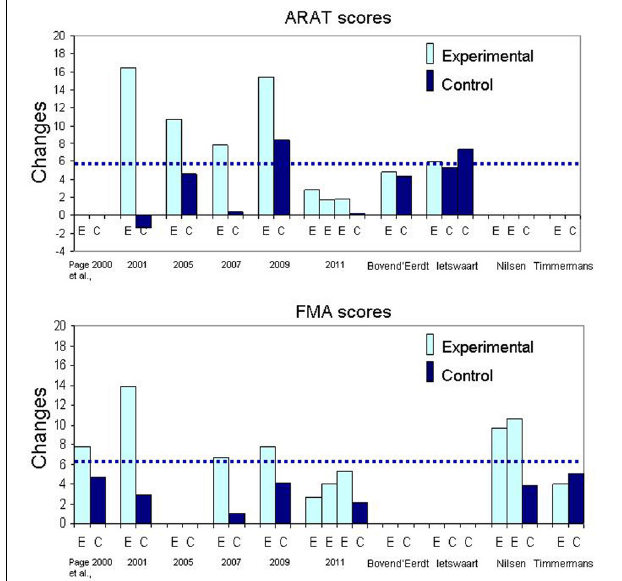
FIGURE 2 | Bar graphs illustrating the mean changes in Arm Research Action Test (ARAT) and Fugl-Meyer Assessment (FMA). The dotted line represents the Minimal Clinically Important Difference (MCID) for each outcome